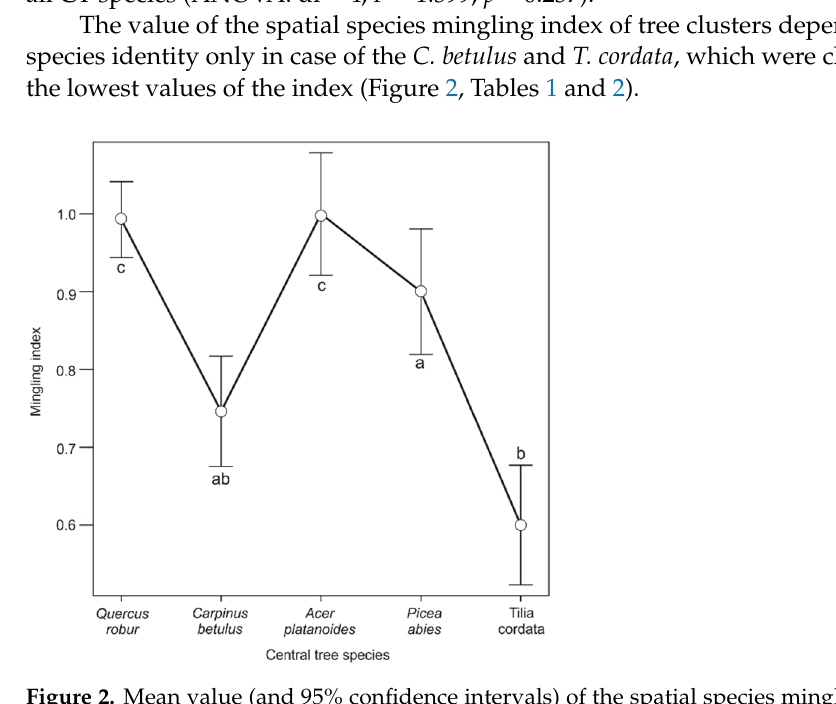
Figure 2. Mean value (and 95% confidence intervals) of the spatial species mingling index of tree clusters associated with large trees of Quercus robur , Carpinus betulus , Acer platanoides , Picea abies , and Tilia cordata in Bia ł owie ż a Primeval Forest; letters a–c express significant differences in mingling index value between tree clusters.